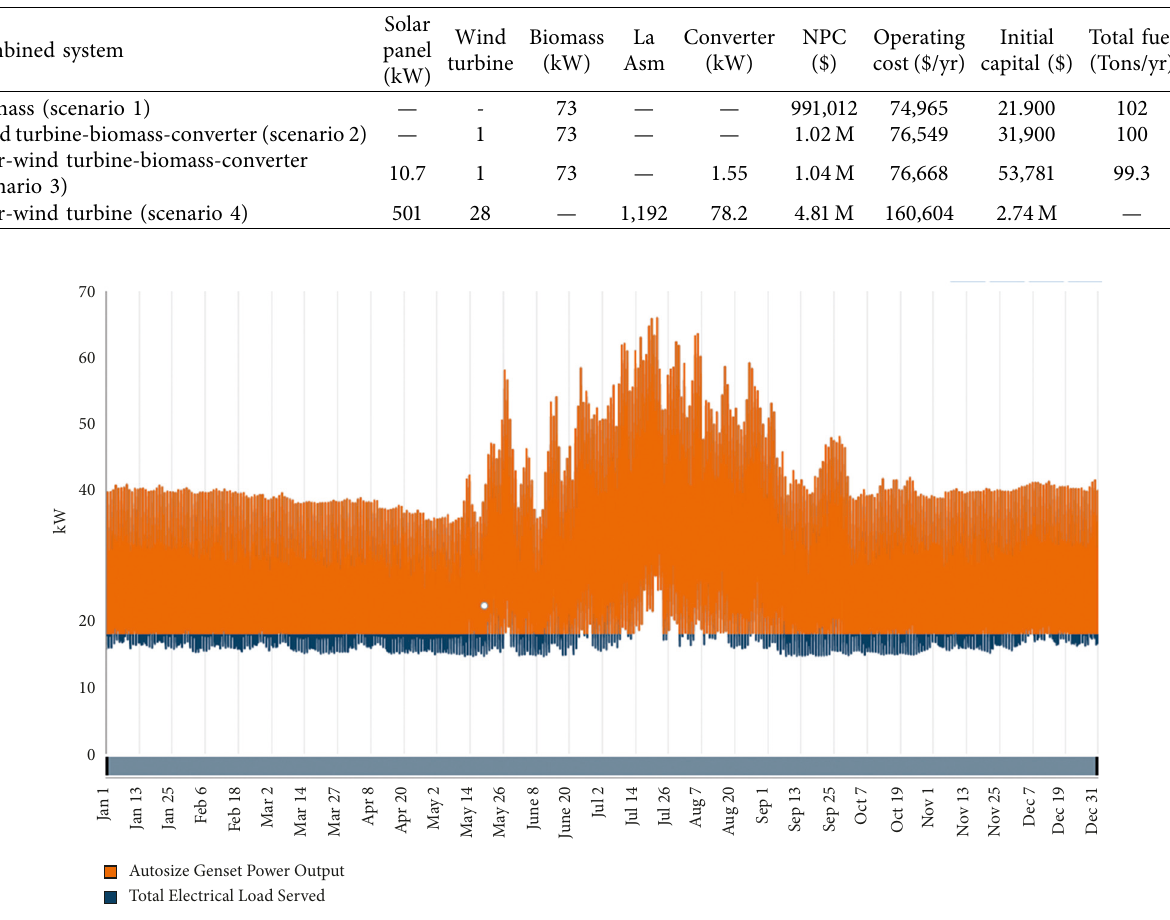
Figure 2: Energy production in different months of the year (Scenario 1).